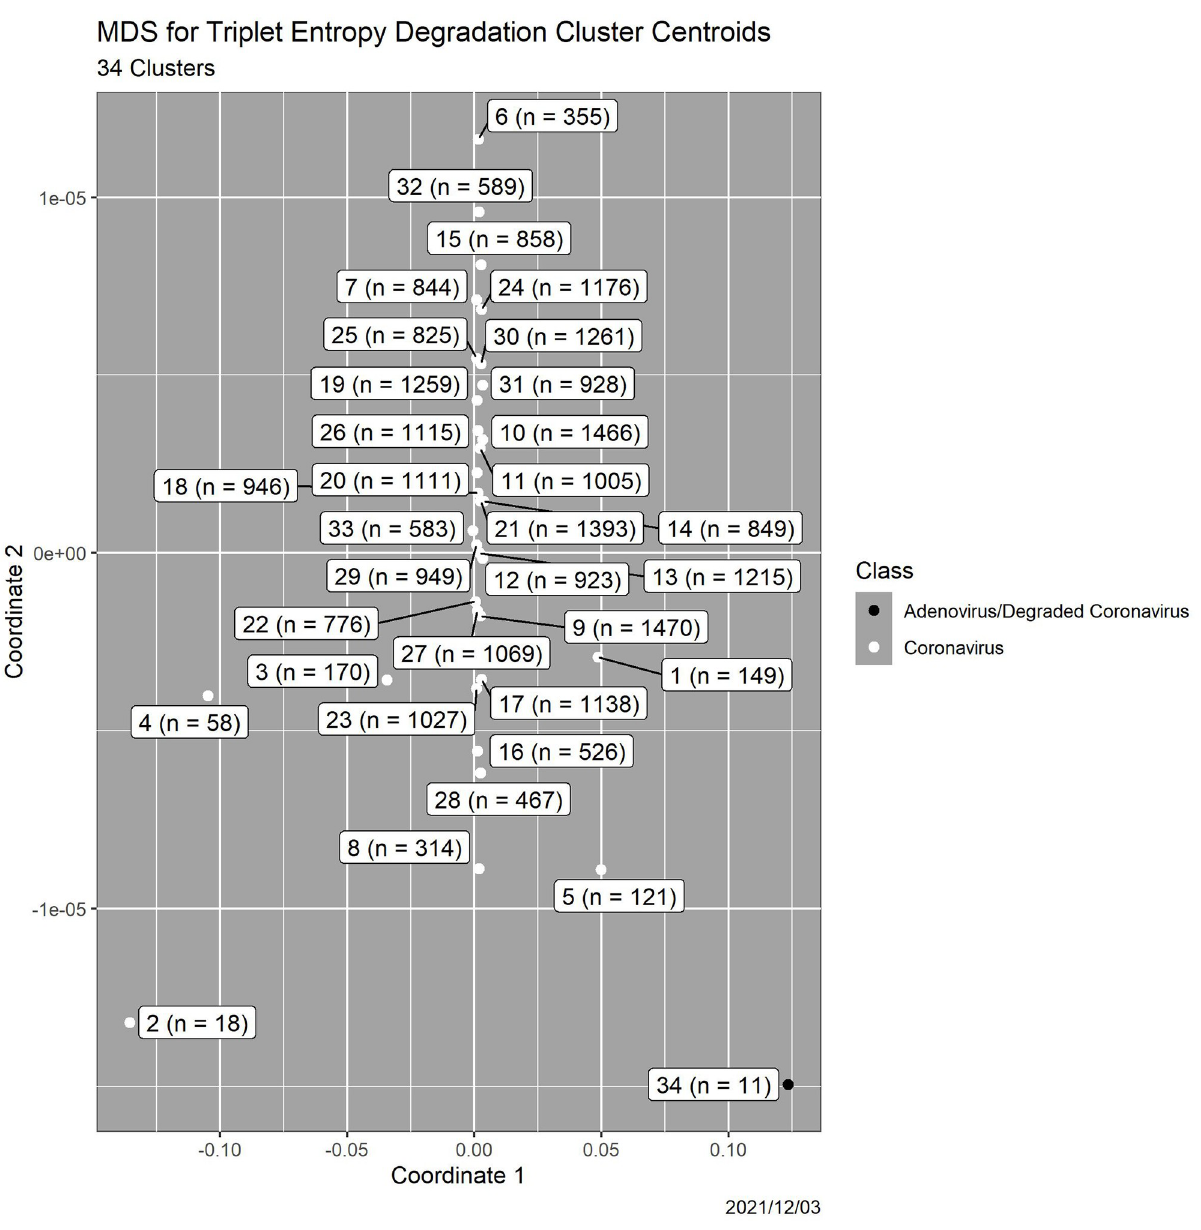
Fig 8. Results for triplet entropy clustering. Two-dimensional MDS plot of the 34 cluster centroids. Labels are cluster numbers and counts. Greater distance implies higher